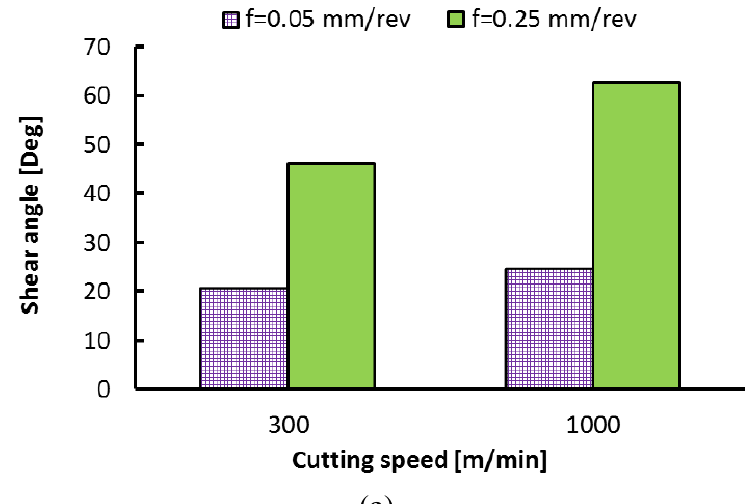
Figure 19. Effect of cutting speed on ( a ) shearing and ( b ) friction